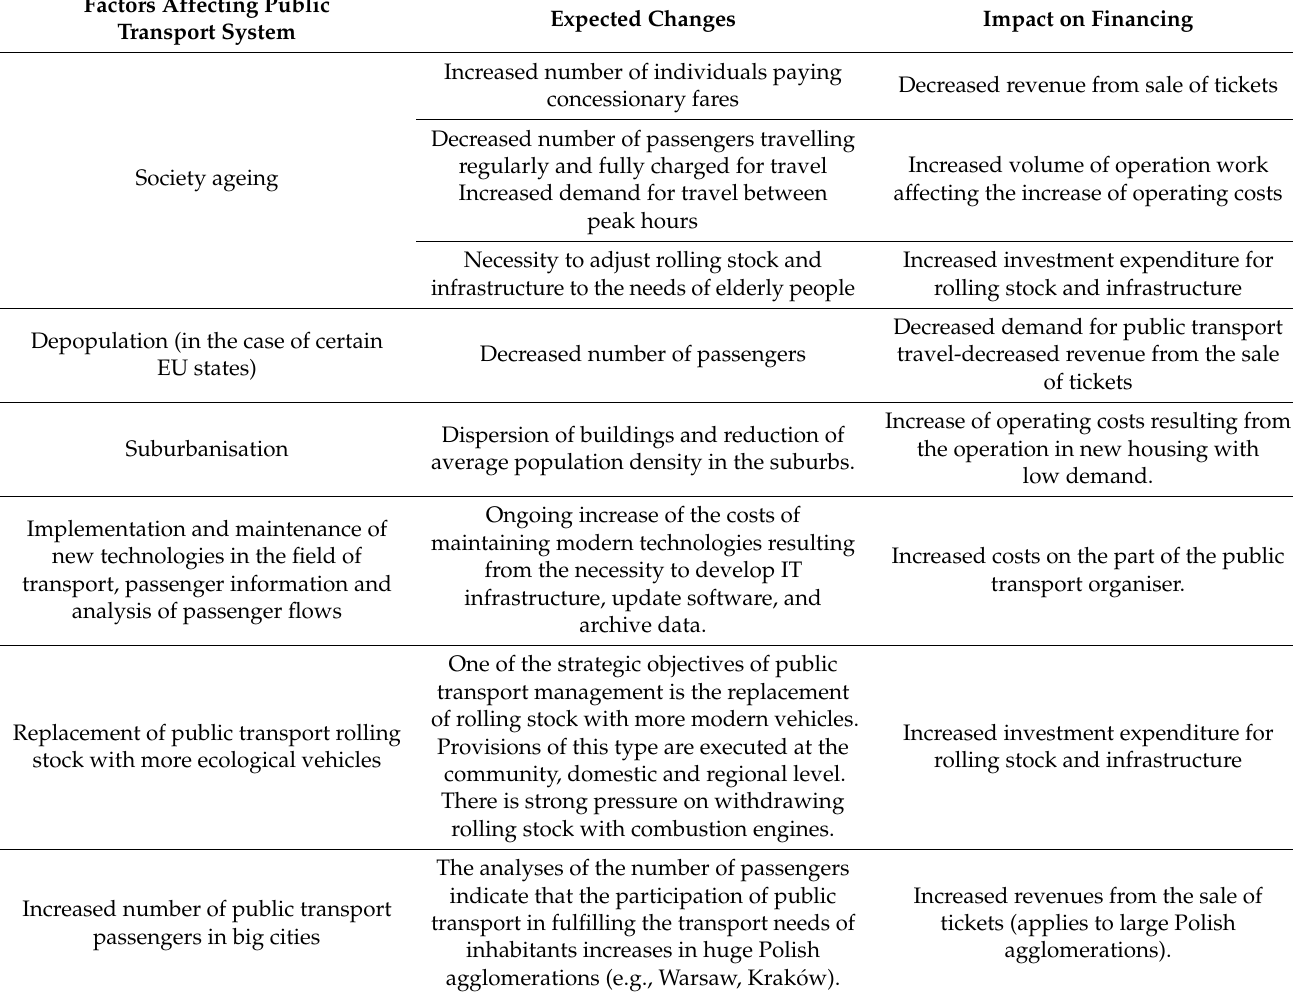
Table 1. Factors impacting the level of public transport financing (in Polish